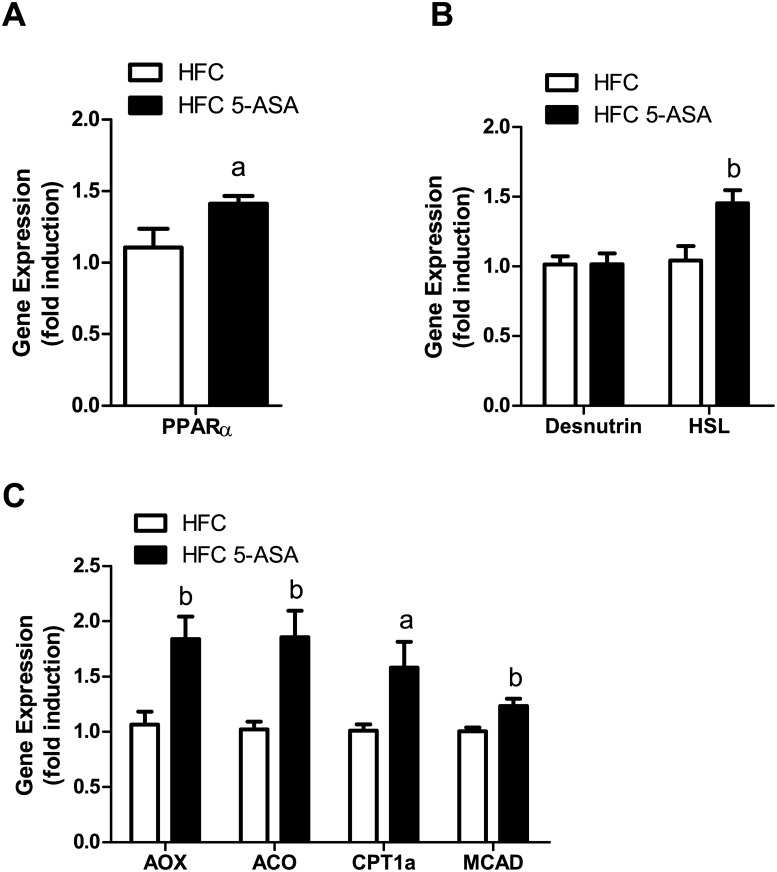
Effects of 5-ASA intervention on fatty acid oxidation in small intestine.(A) qPCR analysis of small intestinal lysates for gene expression of PPARα. (B) qPCR analysis of small intestinal lysates for gene expression of Desnutrin and HSL. (C) qPCR analysis of small intestinal lysates for gene expression of AOX, ACO, CPT1α and MCAD. Data are presented as means ± SEM, n = 9–10 mice, aP < 0.05 vs. HFC, bP < 0.01 vs. HFC.